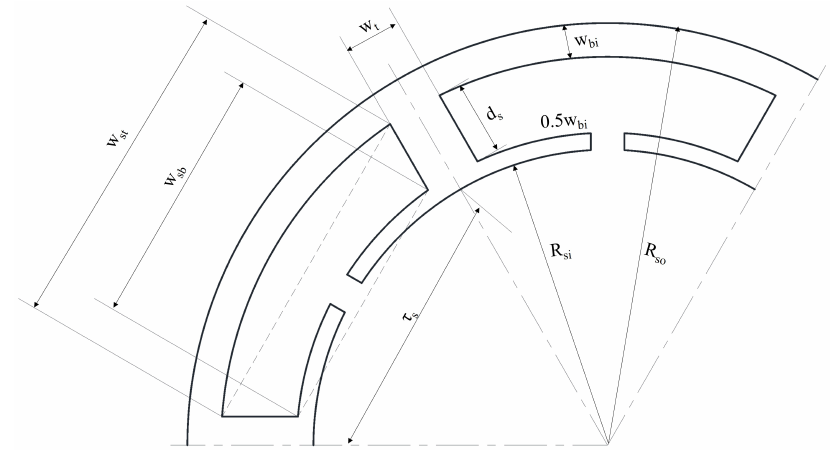
Figure 6. Geometric parameters of the electromagnetic driver stator core.